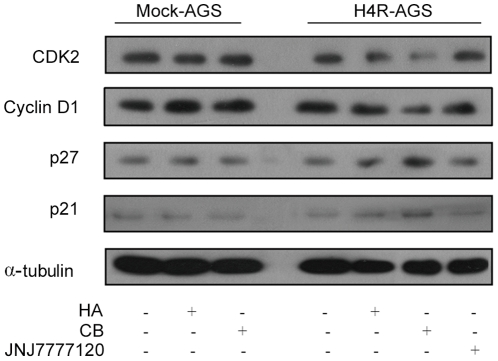
Expressions of cell cycle proteins regulated by HRH4.Mock-AGS and H4R-AGS were treated as in Fig. 3A, and total cell lysates were examined by western blotting.